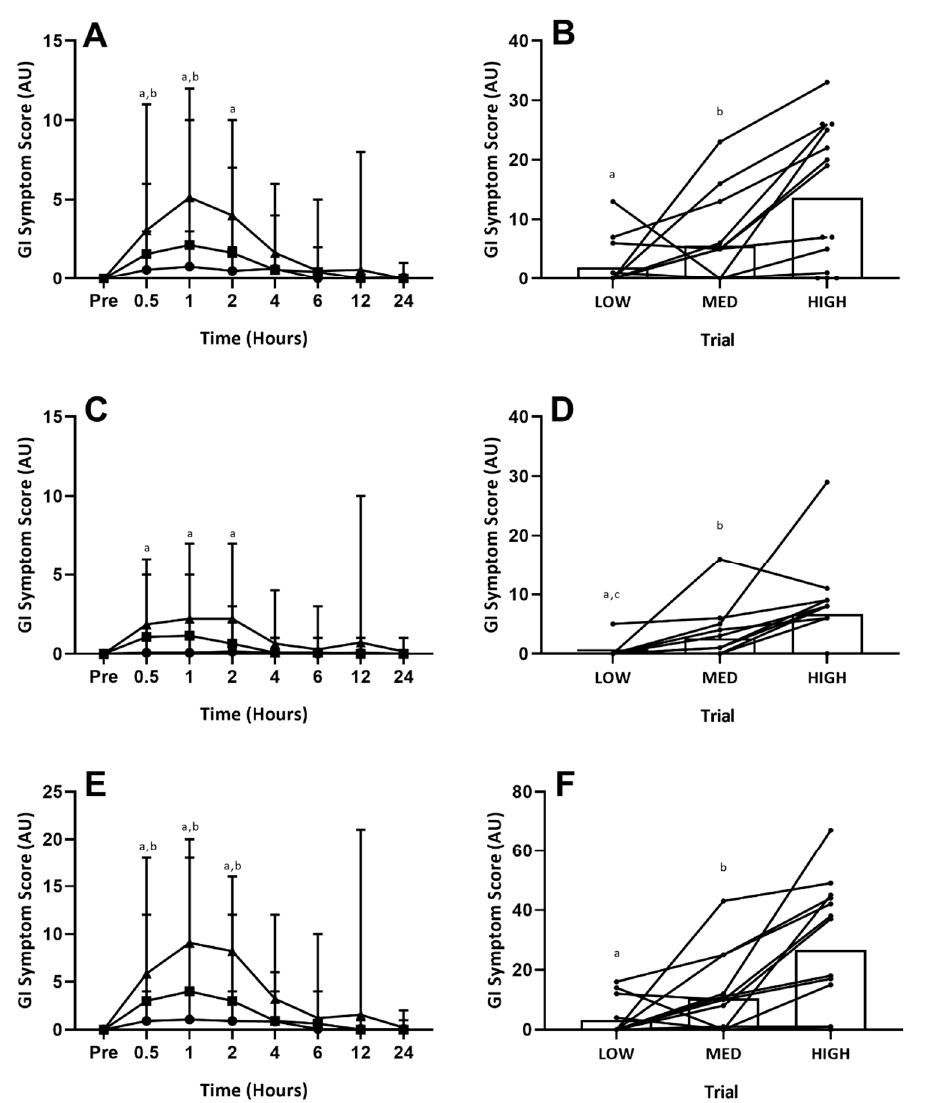
Figure 2. Gastrointestinal Symptoms (Time-Course). GI symptom scores: ( A ) = upper-GI symptoms over time; ( B ) = 24-h accumulated upper-GI symptoms; ( C ) = lower-GI symptoms over time; ( D ) = 24-h accumulated lower-GI symptoms; ( E ) = total-GI symptoms over time; ( F ) = 24-h accumulated total-GI symptoms. Circles = LOW, squares = MID, Triangles = HIGH. On ( B , D , F ) circles = individual participant data. Significant difference between LOW vs. HIGH ( a p ≤ 0.05), MED vs. HIGH ( b p ≤ 0.05) and LOW vs. MED ( c p ≤ 0.05) trials.